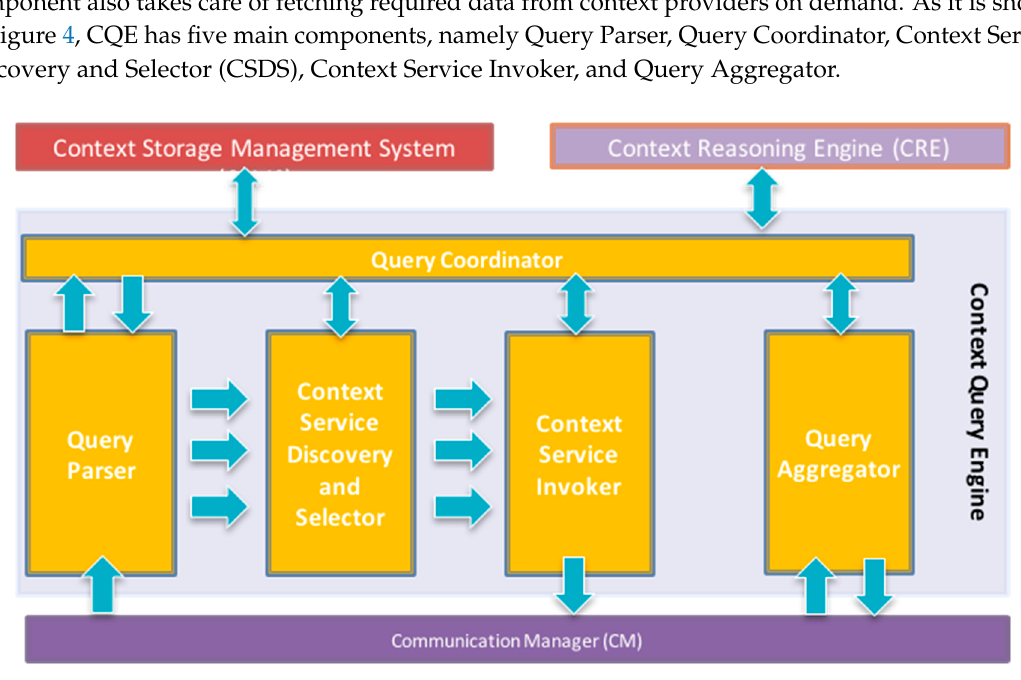
Figure 4. Context query engine architecture.